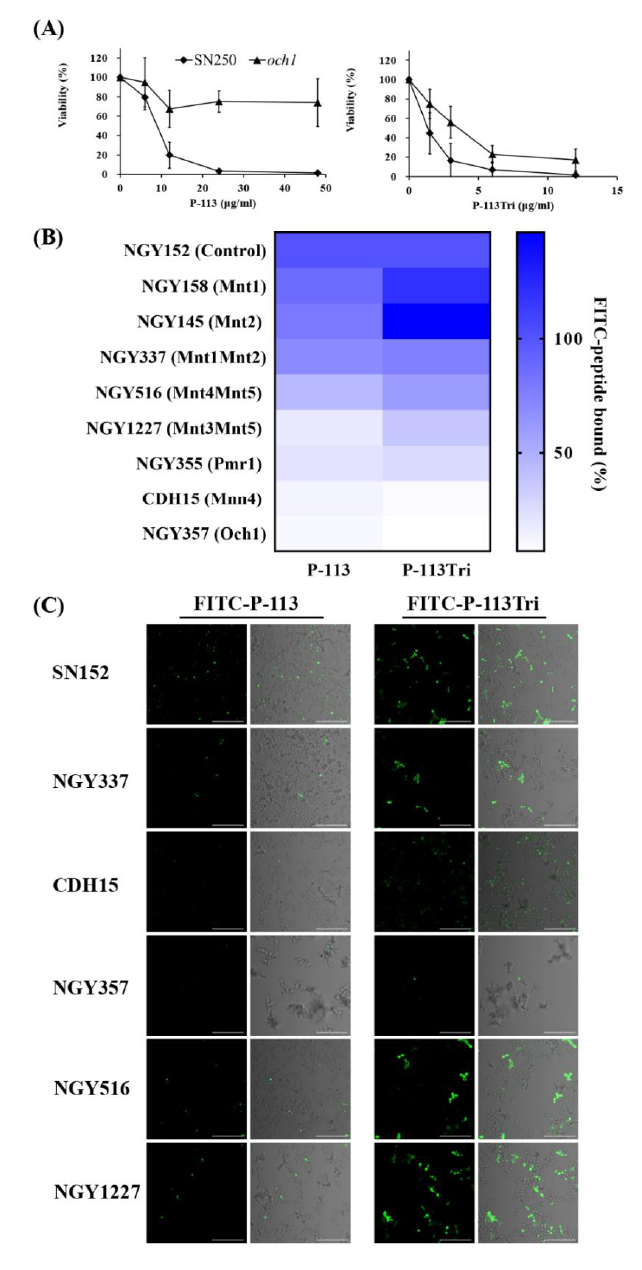
Figure 4. E ff ect of cell wall mannan modification on the peptides and their cell binding and antifungal activity. ( A ) Viability of the C. albicans och1 -deletion mutant after treatment with P-113 and P-113Tri. Cells were treated with di ff erent concentrations of the peptides at 37 ◦ C for 1 h. ( B ) The binding of FITC-P-113 and FITC-P-113Tri to various glycosylation mutants. Cells were incubated with FITC-labeled peptides(0.6 µ g / mL).( C )ConfocalmicroscopicexaminationtodemonstratetheinteractionofFITC-P-113 and FITC-P-113Tri with C . albicans glycosylation mutants. Cells were incubated with FITC-peptides (0.6 µ g / mL). Scale bar, 50 µ